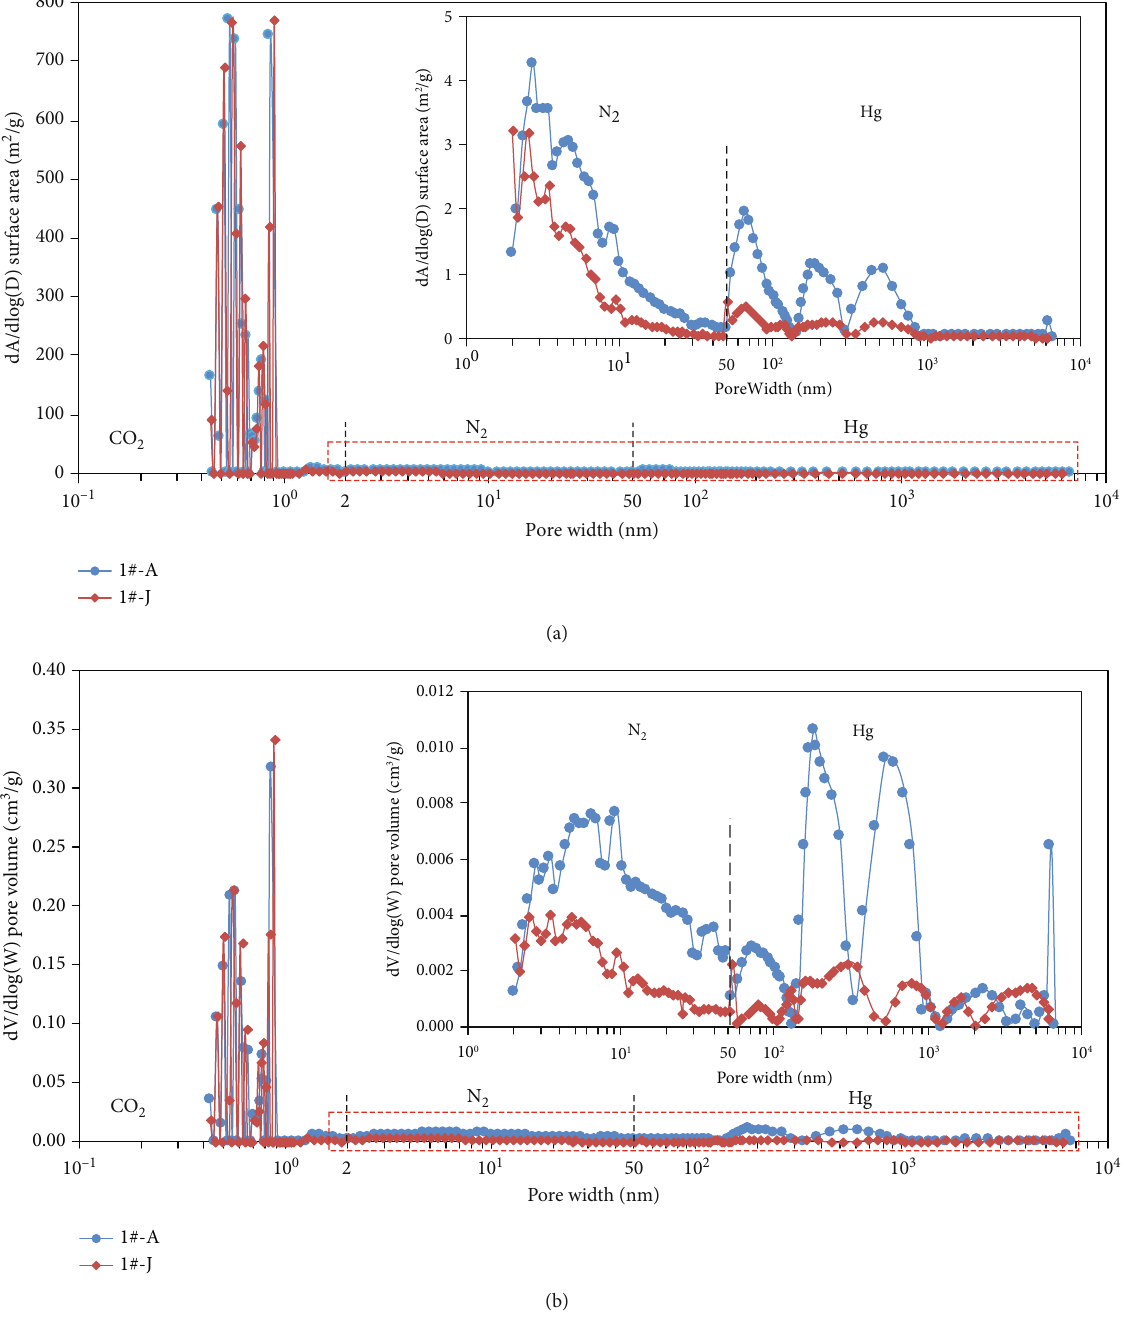
Figure 10: Correlation between the SSA, PV, and pore width of vitrain and durain. (a) Correlation between dA/dlog(D) and pore width; (b) Correlation between dV/dlog(D) and pore